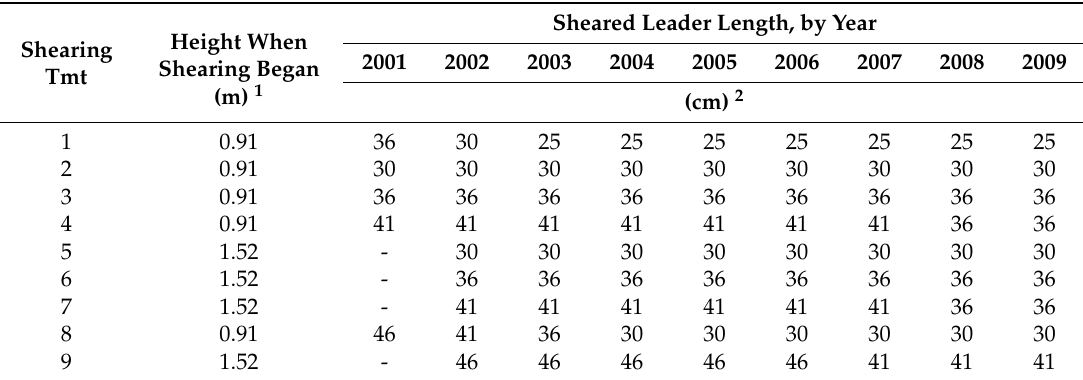
Table 1. Leader lengths used in nine shearing regimes in Fraser fir Christmas trees.